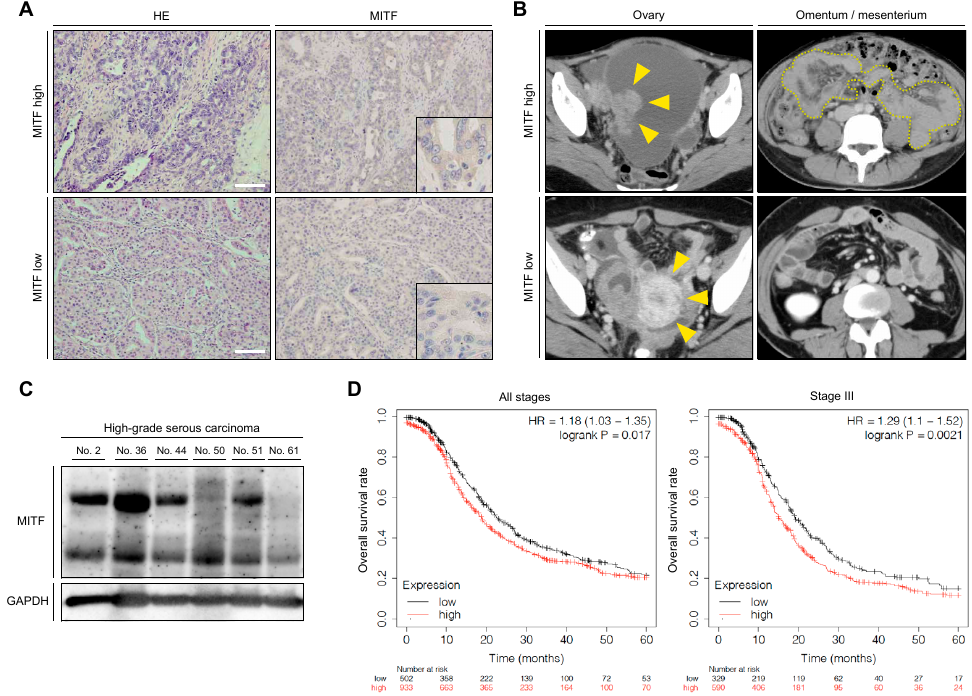
Figure 1. Clinical impact of microphthalmia-associated transcription factor (MITF) expression in ovarian cancer (OvCa) tissue. ( A ) Representative image of the H&E staining and immunohistochemistry of the MITF at a primary OvCa site. Scale bar: 100 µ m. ( B ) Representative image of computed tomography in patients with high and low MITF expression in OvCa tissue. Arrowheads indicate the primary OvCa site and the enclosed area highlights peritonitis carcinomatosis. ( C ) Immunoblot analysis of the tissue samples extracted from primary OvCa. ( D ) Kaplan–Meier curves of progression-free survival in all patients and those with stage III OvCa, stratified by differences in MITF expression.